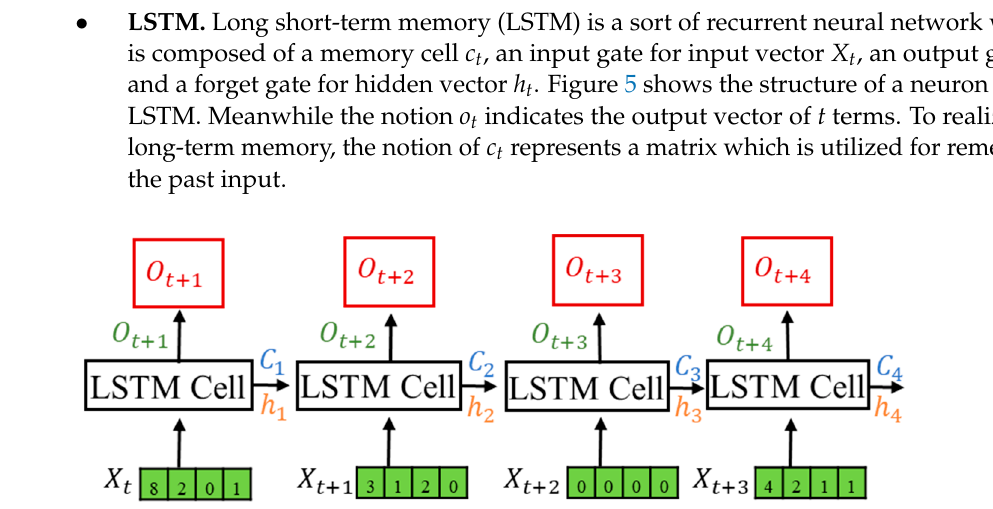
Figure 5. Illustration of LSTM in our proposed framework.